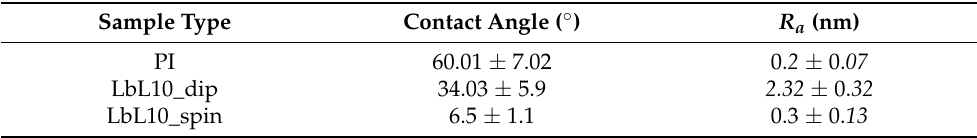
Table 1. Summary of physiochemical properties of untreated and LbL-coated